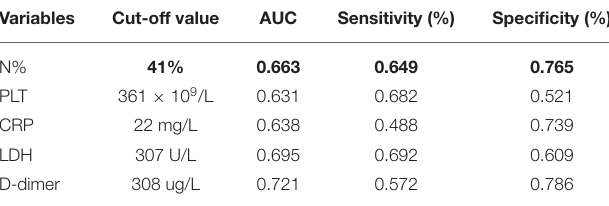
TABLE 4 | Complications comparison between elevated D-dimer group and control